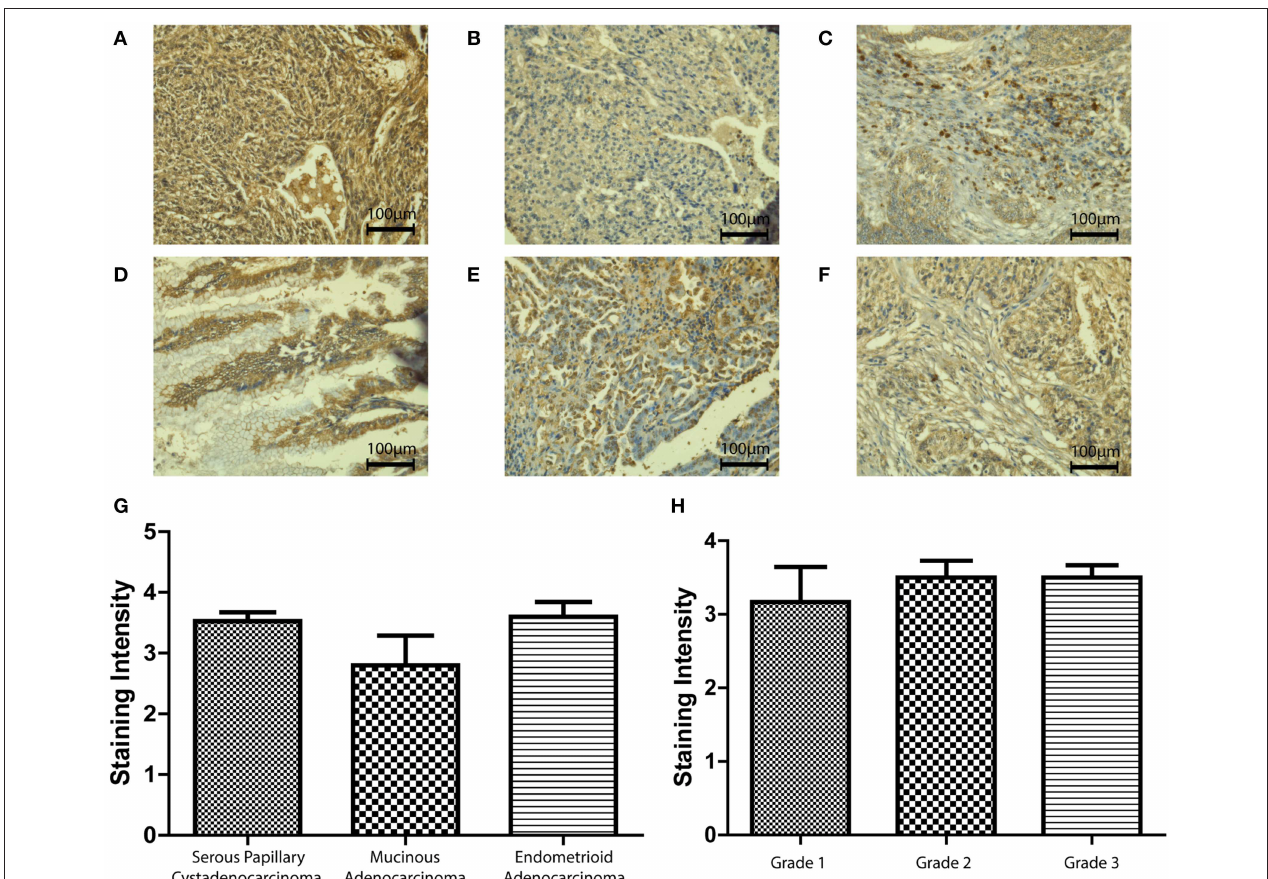
FIGURE 3 | Immunohistochemistry for SP-D expression in different pathologies of ovarian tissue array clinical samples (40x magnification): serous papillary cystadenocarcinoma (A) , mucinous adenocarcinoma (B) and endometrioid adenocarcinoma (C) . No significant change was seen between different types of OC ( p = 0.2235; G ). Immunohistochemistry for SP-D expression in different grades of ovarian tissue array clinical samples: mucinous cystadenocarcinoma grade 1 (D) , serous papillary cystadenocarcinoma grade 2 (E) and serous papillary cystadenocarcinoma grade 3 (F) . No significant change was seen between different grades of disease ( p = 0.7055, H